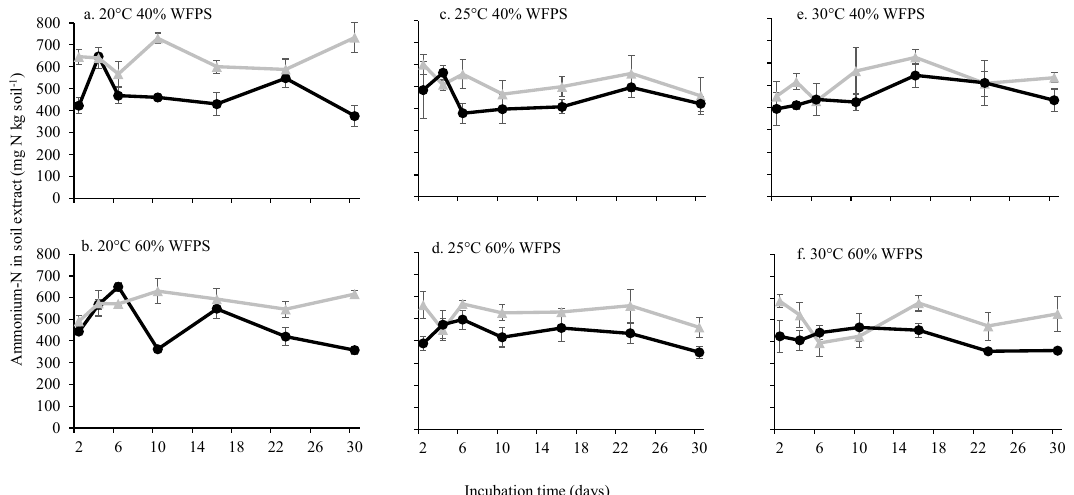
Figure 3. Effect of temperature and water-filled pore space (WFPS) on soil ammonium concentrations following the application of urea (black circles) or DMPP–urea (grey triangles) to an acidic Gleysol soil incubated for 30 days. Error bars depict SEM ( n = 3).